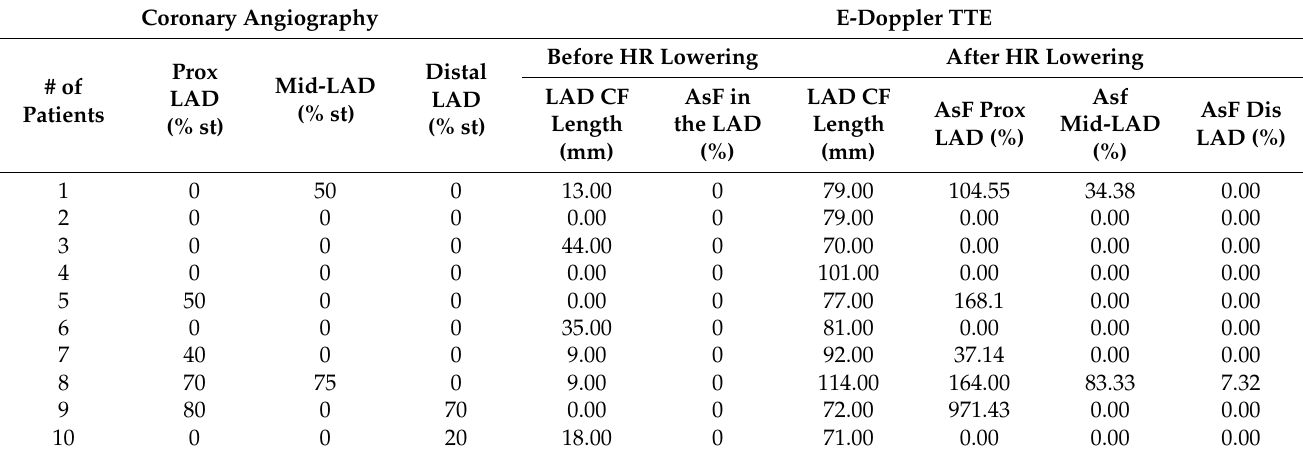
Table 3. List of angiographic and E-Doppler TTE LAD findings in 10